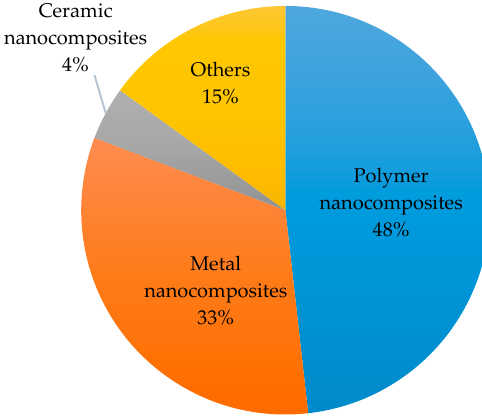
Figure 5. The publication statistics related to various types of nanocomposites out of a total of 2725 publications—topic: “nanocomposites and applications” [151].